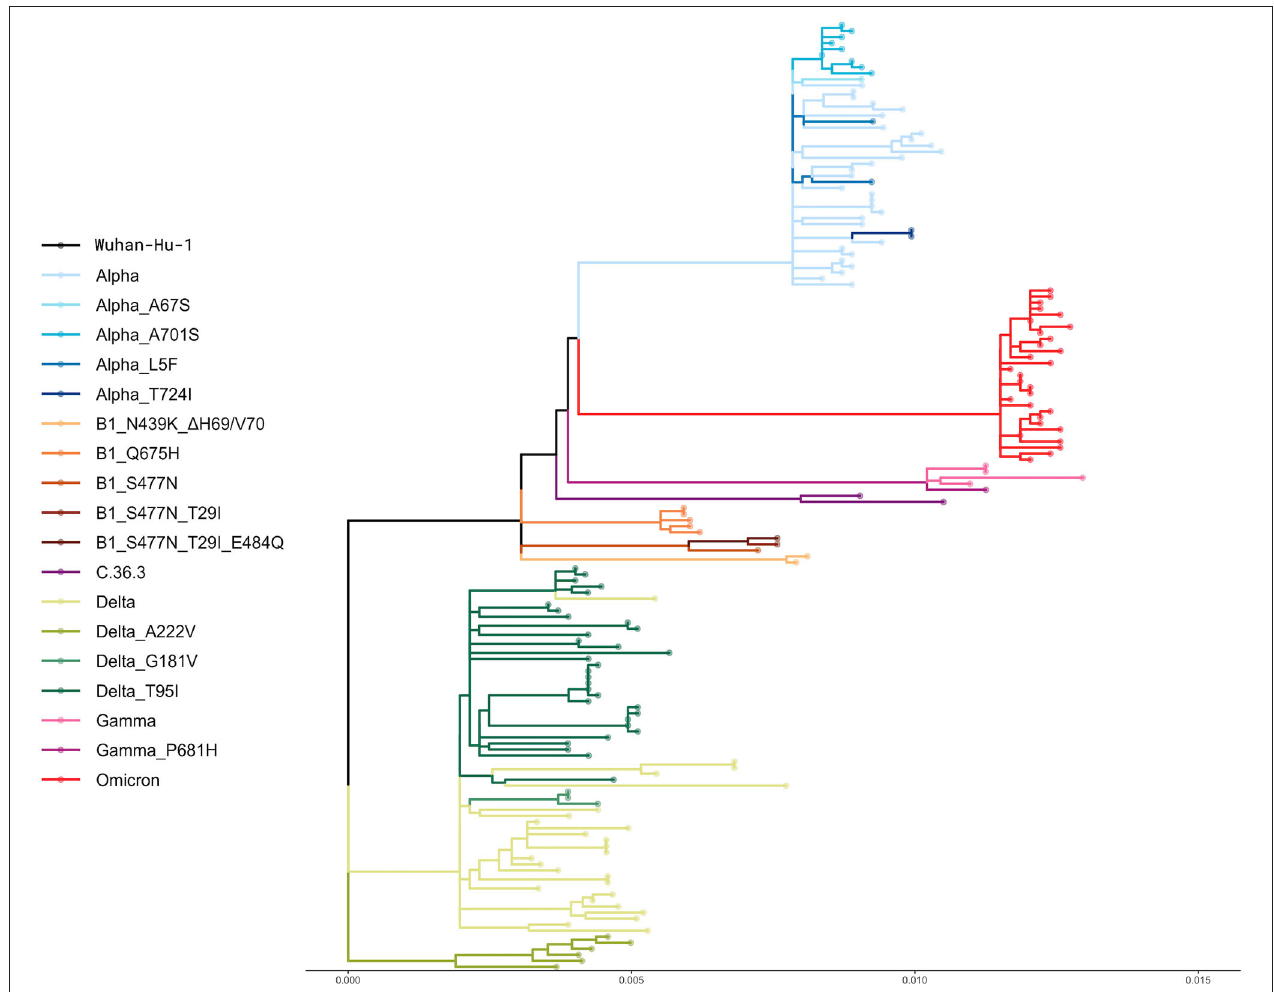
FIGURE 2 | Phylogenetic analysis. The phylogenetic tree shows the genetic relationship between the 157 whole genomes included in this study. A default bootstrap equal to 100 was used. The genetic distance is reported at the bottom.